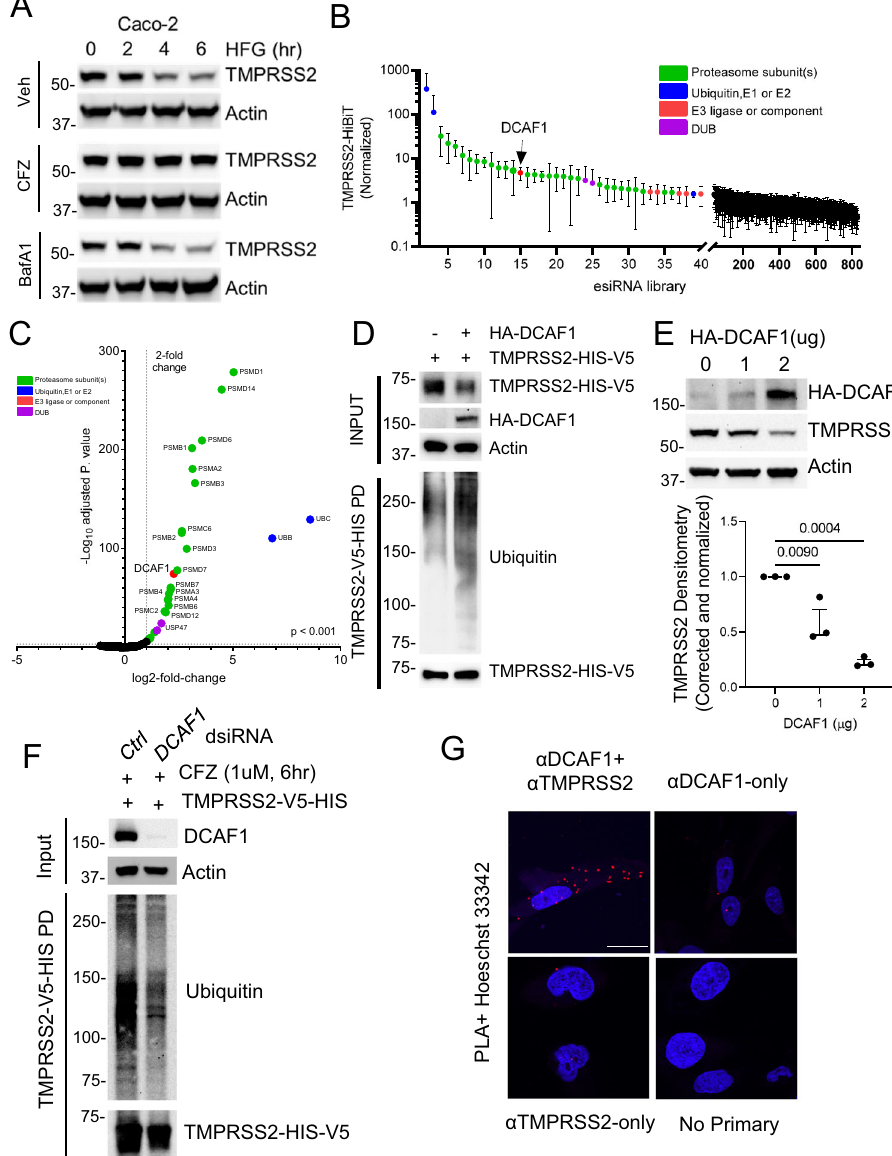
Fig. 5 TMPRSS2 is degraded through ubiquitin proteasome system, which is required for HFG ef fi cacy. A Immunoblotting assay of Caco-2 cells treated with HFG (3 µ M) in combination with car fi lzomib (CFZ, 1 µ M) or ba fi lomycin A1 (BafA1, 1 µ M) and probed for TMPRSS2. B , C TMPRSS2-HiBiT signal was measured following siRNA knockdown of ubiquitination-related machinery. B Ubiquitination siRNA library screening results ordered by increase in TMPRSS2-HiBiT signal. The E3 ligase DCAF1 was detected as a top hit. Data are mean ± SD ( n = 3 biologically independent samples). C Volcano plot